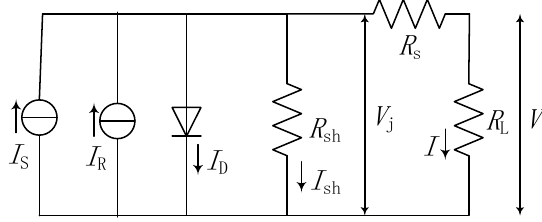
Figure 2. Equivalent circuit model of the multi-source harvester.